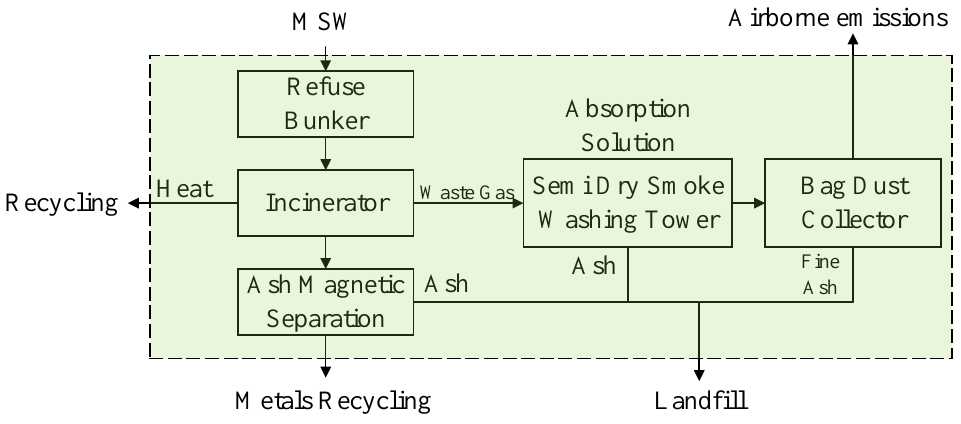
Figure 2. Schematic processing flowchart of municipal solid waste (MSW) sanitary landfill [70].